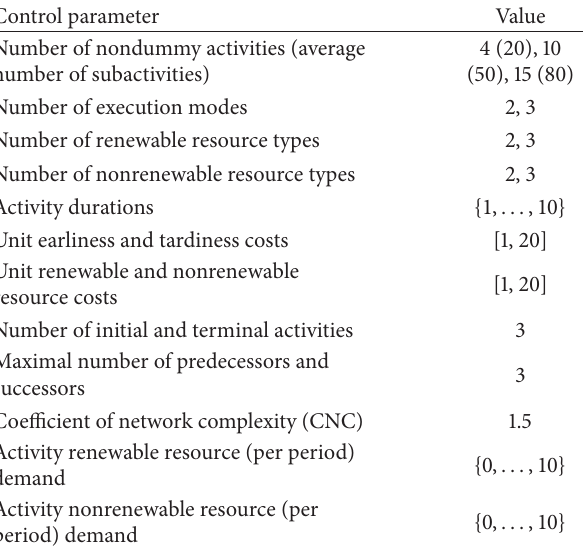
Table 2: The parameter settings for the problem set.